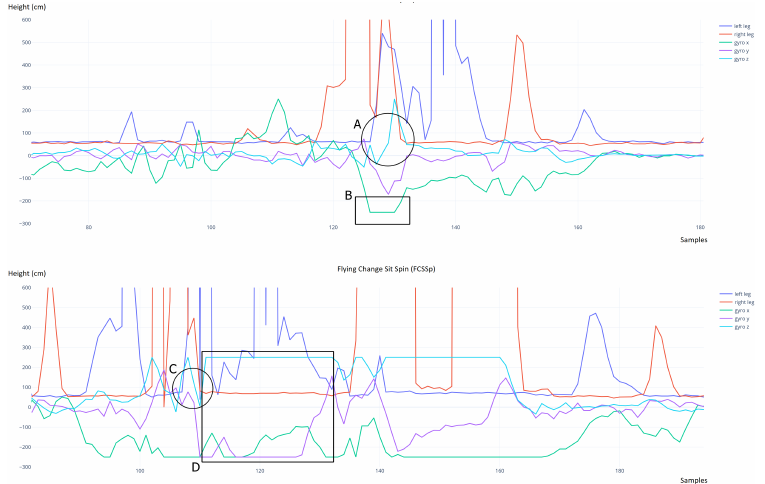
Figure 11. A comparison between a double Lutz ( upper chart ) and a flying sit spin with foot change ( lower chart ). The gyroscope hard limit was reached while jumping (the cyan line in the B area above) rather than after landing (the cyan line in the D area below).